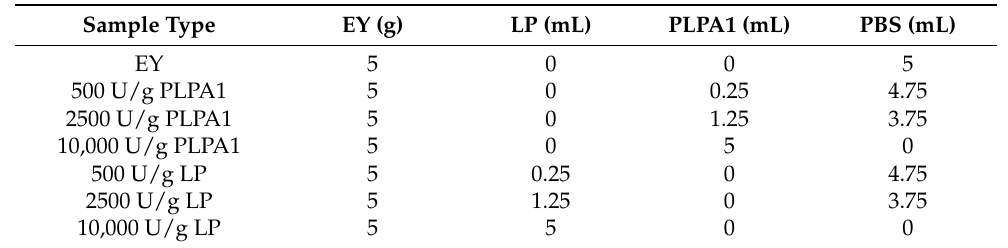
Table 1. Proportions of components in enzymatic EY system (The density of PLPA1 and LP solution is 1 g/mL).